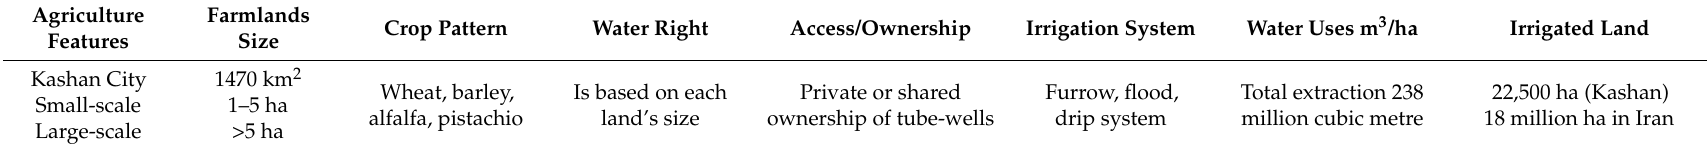
Table 1. Characteristics of farming systems in Kashan.